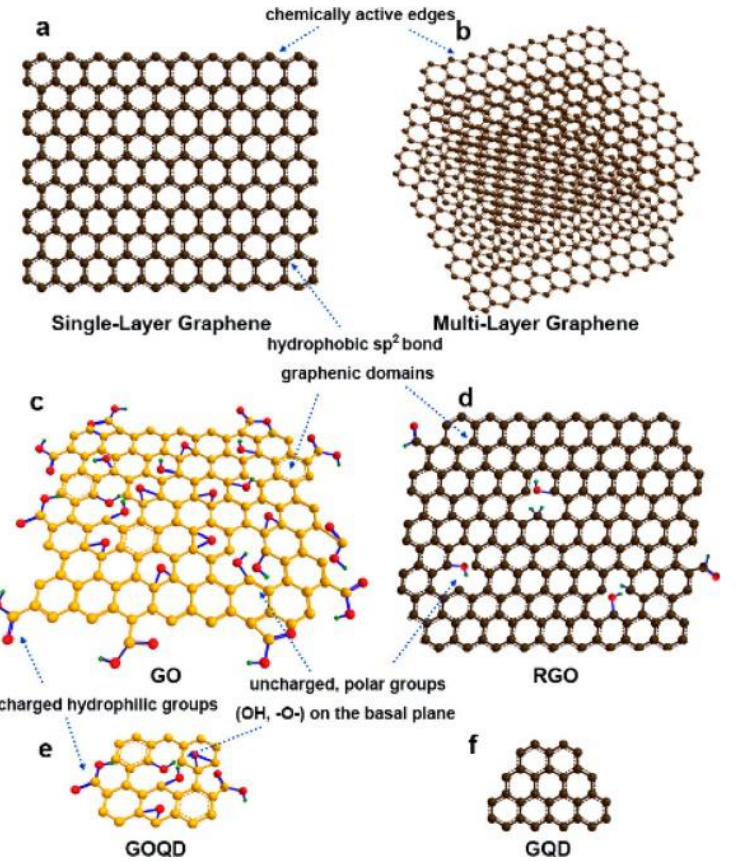
Figure 16. Graphene nanostructures: ( a ) single-layer graphene, ( b ) multi-layer graphene, ( c ) graphene-oxide, ( d ) reduced graphene-oxide, ( e ) graphene-oxide quantum dots, and ( f ) graphene quantum dots. Reprinted with permission from Ref. [71]. 2017, American Chemical Society.